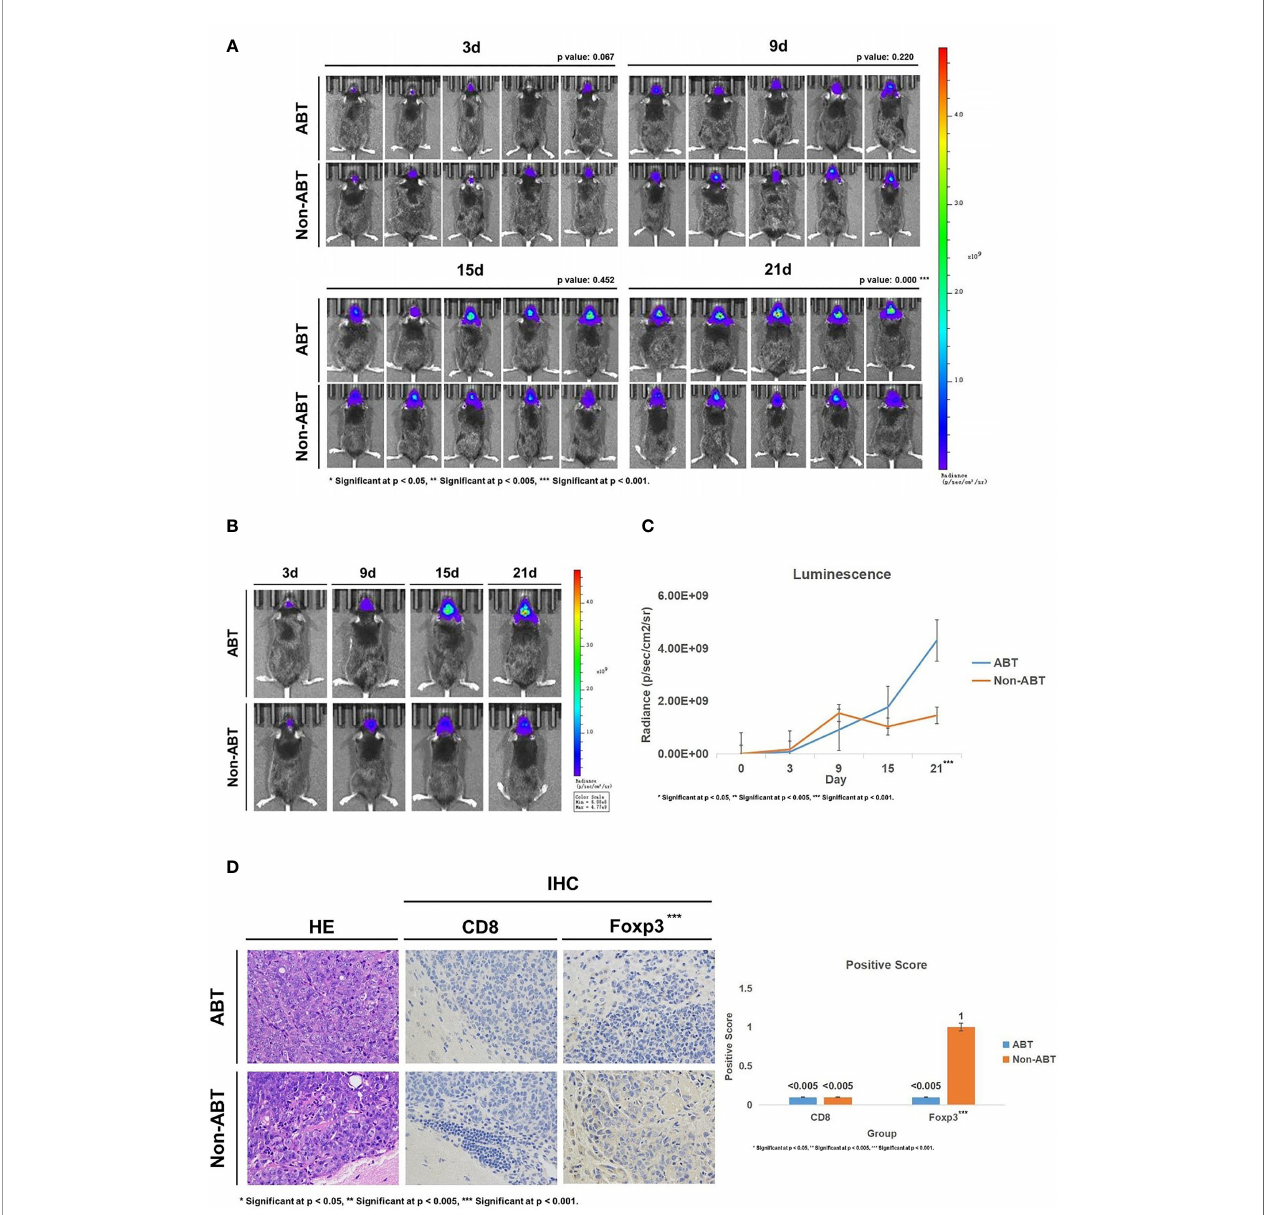
FIGURE 3 | (A) Living image results of glioma tumor growth in mice (n = 5). The living image was performed on mice at 3, 9, 15, and 21 days of glioma growth. ABT: the group with antibiotic treatment. Non-ABT: the group without antibiotic treatment. (B) Living image results of glioma tumor growth in mice (n = 1). Living image was performed on mice at 3, 9, 15, and 21 days of glioma growth. ABT: the group with antibiotic treatment. Non-ABT: the group without antibiotic treatment. (C) Luminescence curve of glioma in living image (n = 5). ABT: the group with antibiotic treatment. Non-ABT: the group without antibiotic treatment. (D) The expressions of CD8 and Foxp3 in the ABT group and non-ABT group were detected by immunohistochemistry (×400 magni fi cation). ABT: the group with antibiotic treatment. Non-ABT: the group without antibiotic treatment. ***Signi fi cant at p <